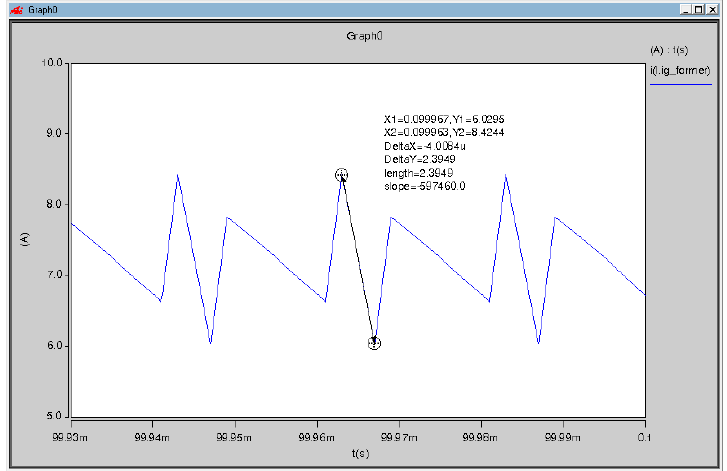
Figure 18. Zoom in the input current ripple for the former strategy when G = 6.5, D = 0.7994 ( k d = 0.5).